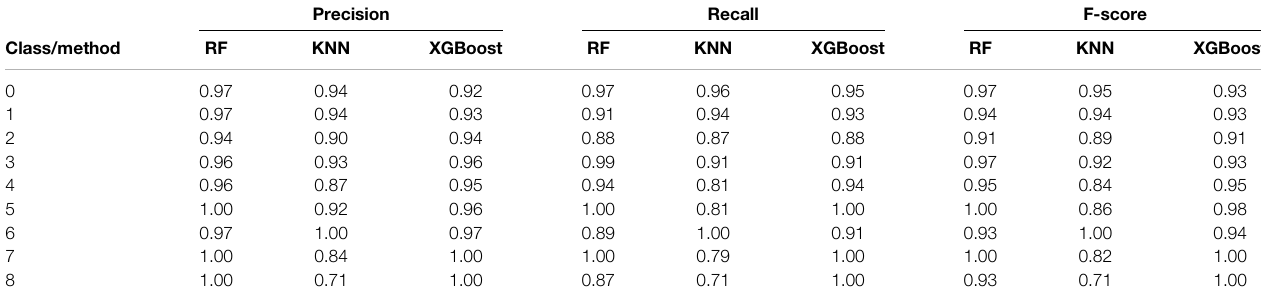
TABLE 2 | Performance metrics in different algorithms (test set). Precision Recall F-score